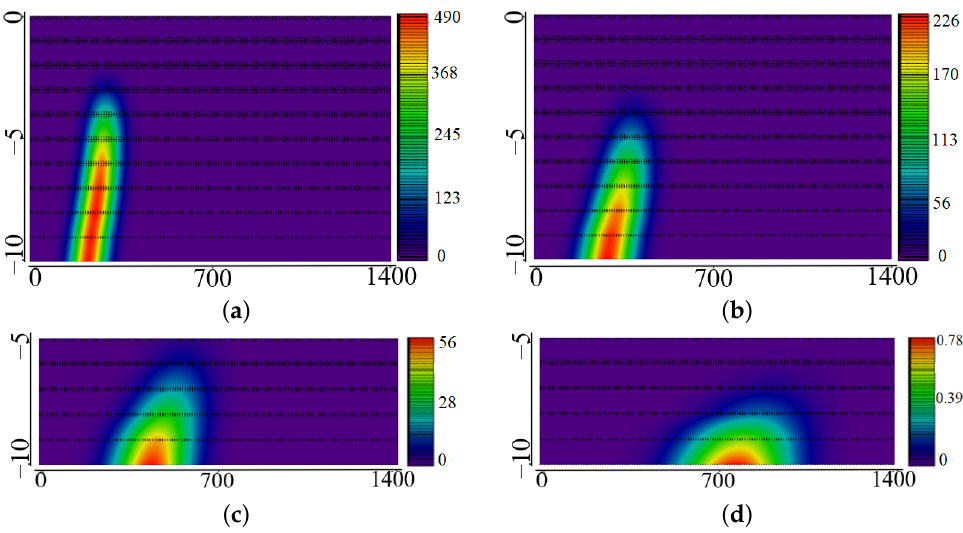
Figure 6. The values of the concentration field of suspended particles for different calculated intervals after the moment of unloading the hold: ( a ) after 15 min; ( b ) after 30 min; ( c ) after 1 h; ( d ) after 2